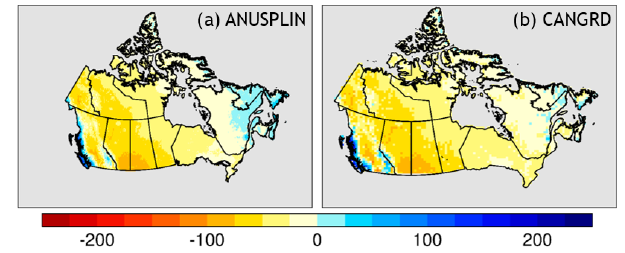
Figure 3. Spatial structure of long-term mean monthly water sur- plus/deficit (mm), i.e. P -PET, derived from ANUSPLIN (a) and CANGRD (b) . Table 2. Percentage of grids with decreasing (Dec.) and increasing (Inc.) trends for the SPEI. ANUSPLIN Inc.